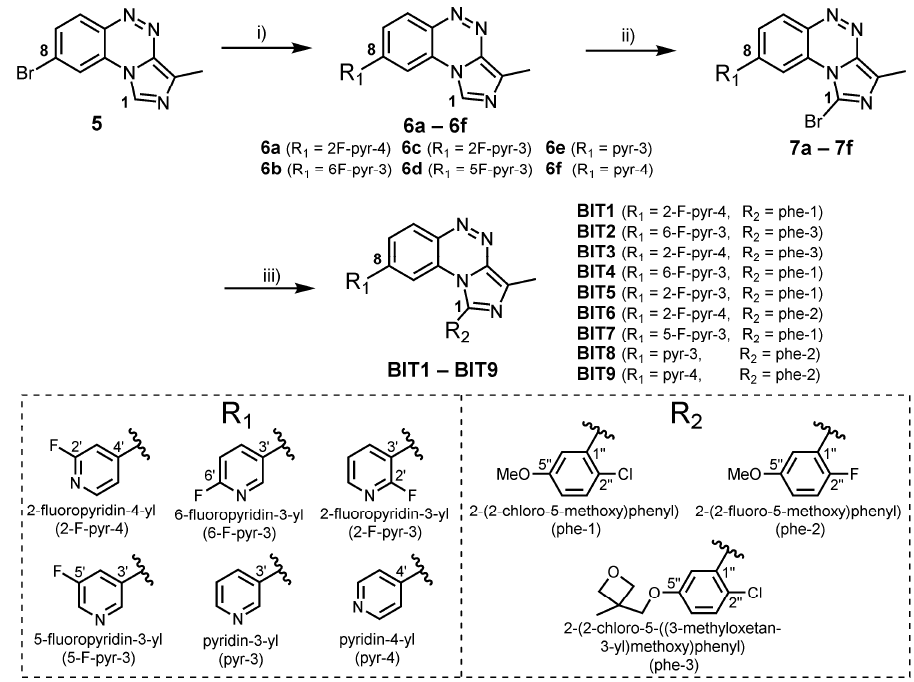
Table 1. Yields of Suzuki coupling with compound 5 (products: 6a – 6f ) and of bromination (products: 7a – 7f